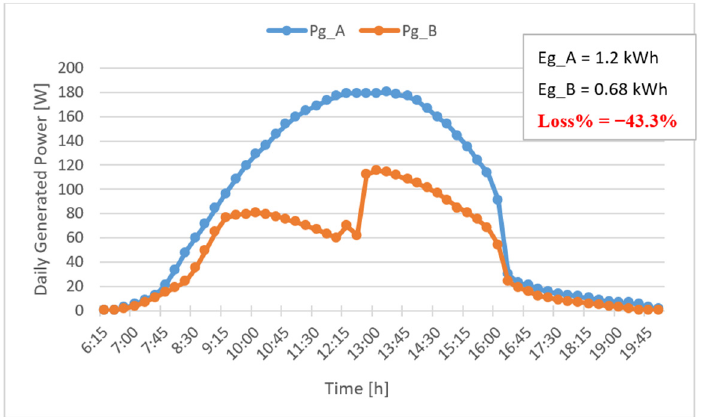
Figure 7. Daily power generation curves, Pg_A and Pg_B, of the two prototypal PV generators A and B on a July 2021 cloudless day, together with corresponding daily generated energy values, Eg_A and Eg_B, and the percentage of energy loss factor, Loss%. In this experiment, a shading plywood sheet was mounted only on three PV cells of the homemade submodule of the PV generator B, and the corresponding bypass diode intervened late, at about 12:30.